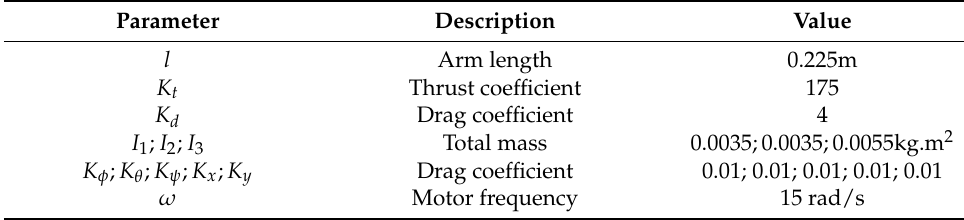
Table 1. DJI F550 Hexacopter parameters.